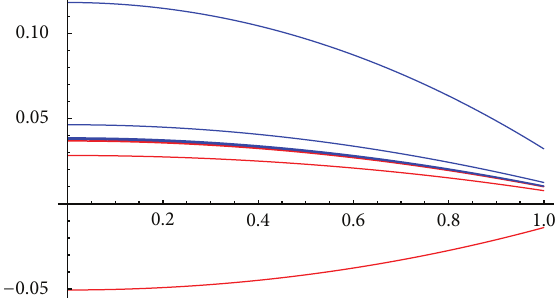
Figure 6: Plot of 𝑢 𝑛 (blue) and V 𝑛 (red), 𝑛 = 1, 2, 3,4, 5 for 𝜆 = −0.2 .